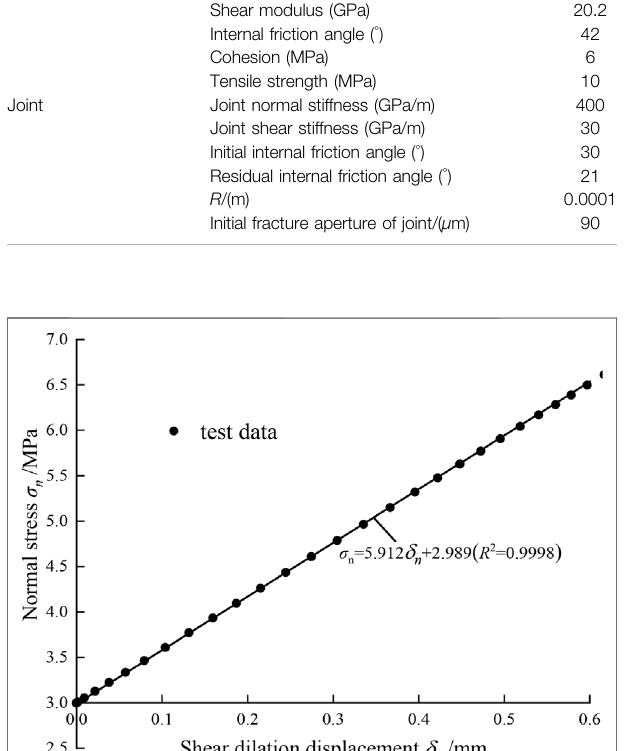
FIGURE 4 | Shear dilation displacement and normal stress relation.